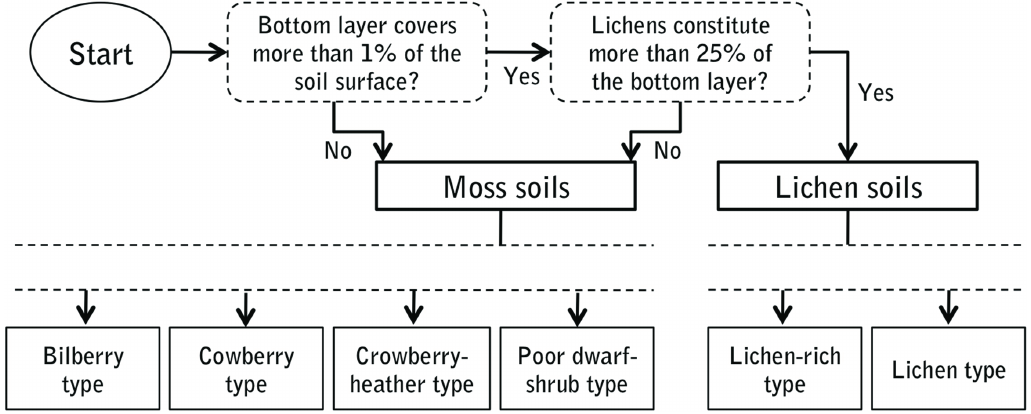
Fig. 1. Scheme for the classification of vegetation type according to Hägglund & Lundmark (1982); see www-markinfo.slu.se/eng/vegeta/vegtyp.html for the complete classification in